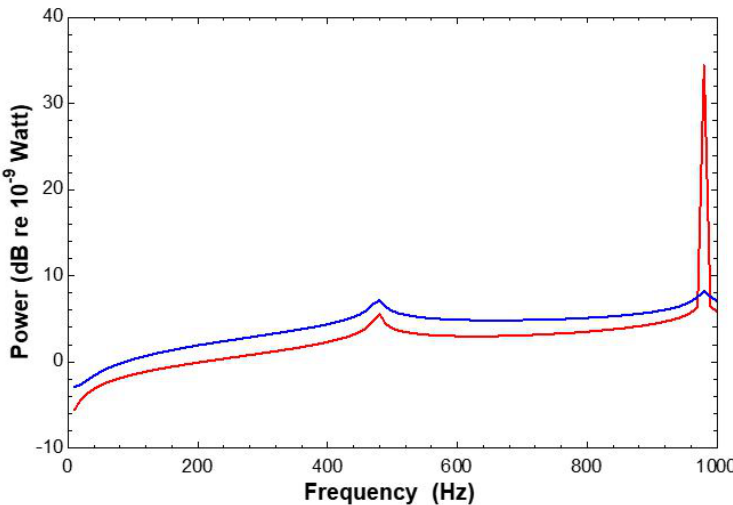
Figure 4. Average power dissipated during phonation for the chain matrix (red) and transmission line (blue) impedance calculation methods for the example 17.5 cm long and 1 cm 2 cross-sectional area hard walled